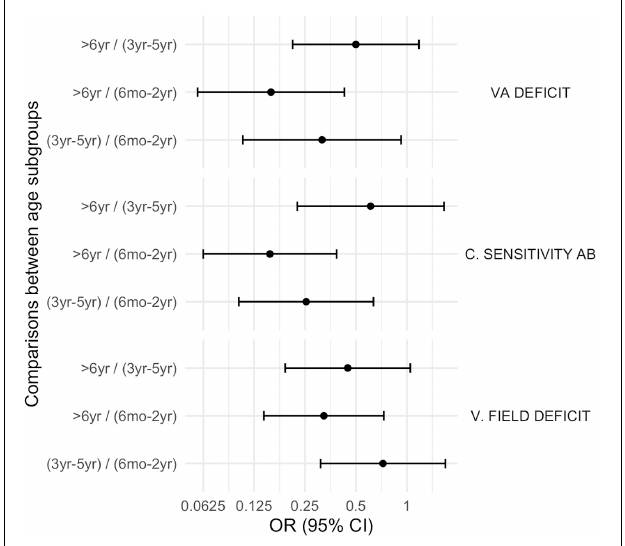
FIGURE 6 | Comparison between subgroups, OR (CI 95%): basic visual function disorders. VA deficit, visual acuity deficit; C. Sensitivity Ab, Contrast Sensitivity abnormalities; V. field deficit, visual field deficit.